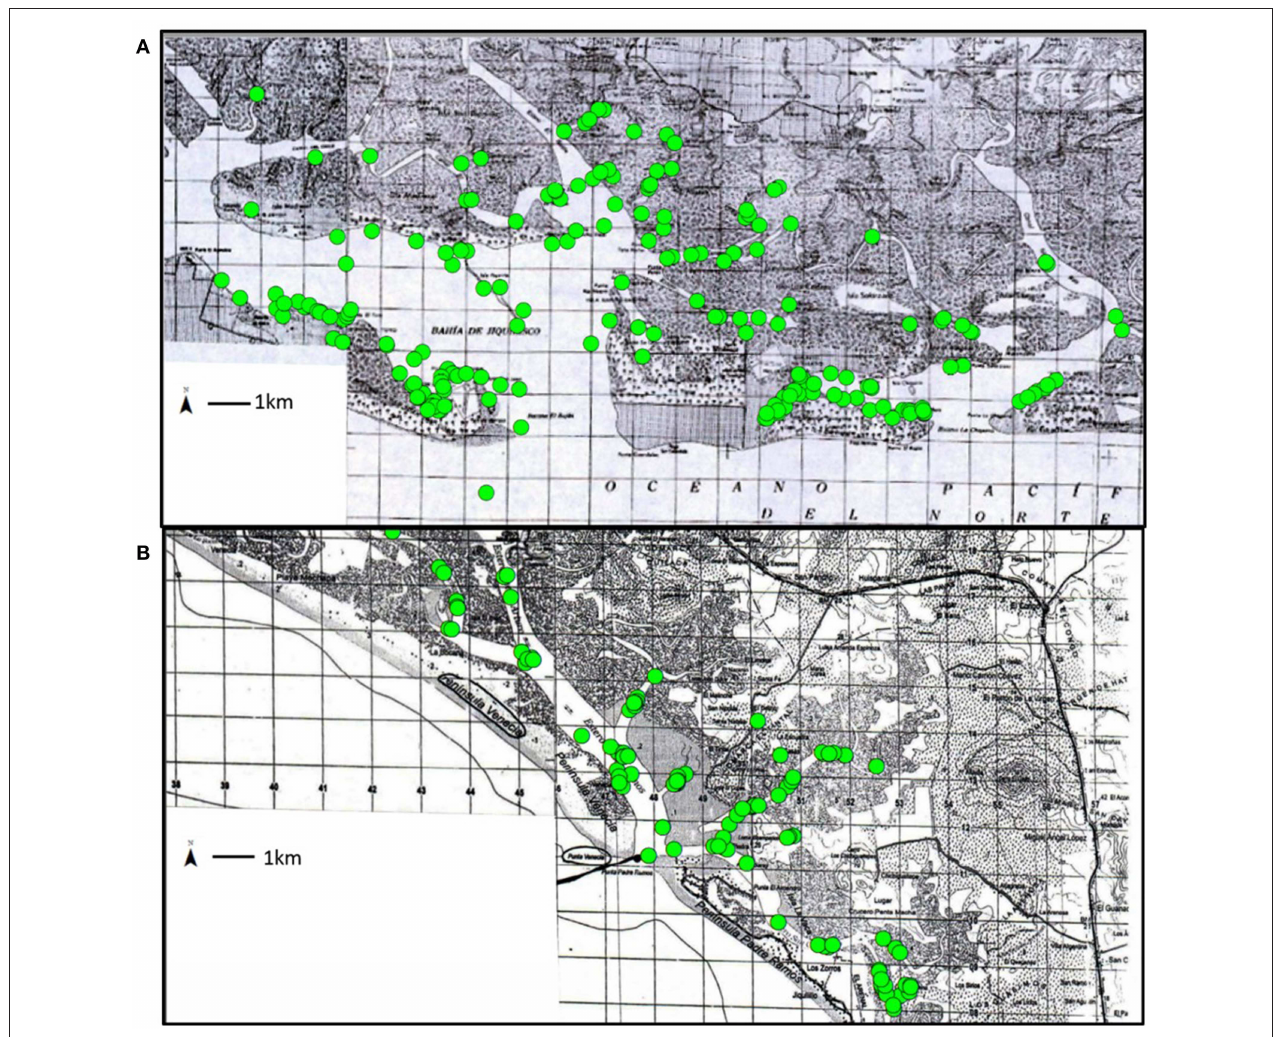
FIGURE 3 | Compiled 301 multidimensional data points from all participatory modeling conducted in (A) Bahía ( N = 38 interviews, 200 data points) and (B) EPR ( N = 30 interviews, 101 data points). Each point represents where a hawksbill turtle has been seen in the water (as opposed to nesting), and each point includes size data of turtles seen at that